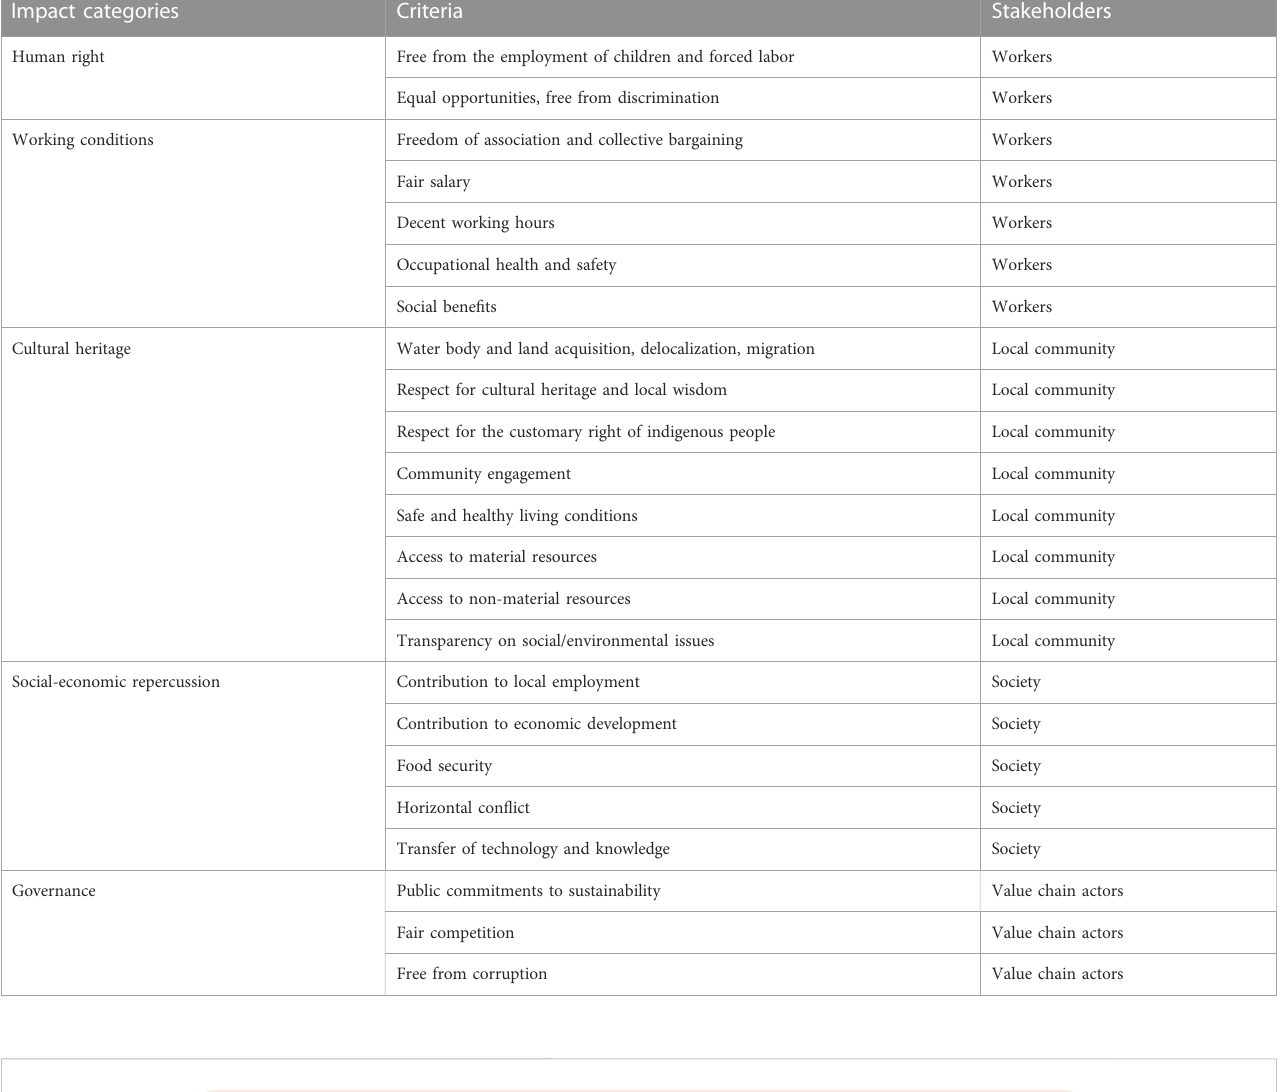
TABLE 2 Impact category and criteria in social life cycle assessment (Manik et al., 2013).